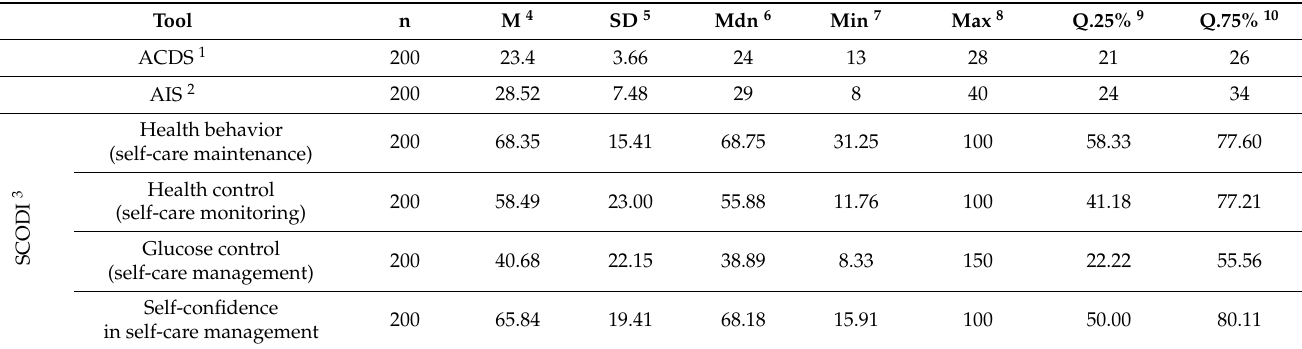
Table 3. Disease acceptance level and adherence to therapeutic recommendations in elderly patients with T2DM. AIS 2 (Points)